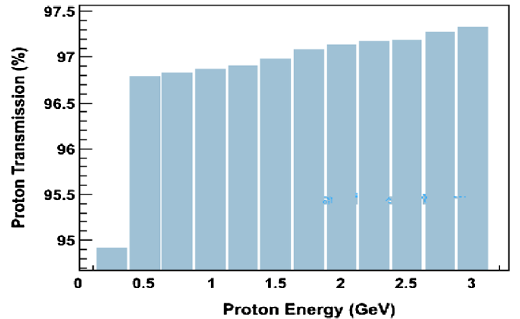
FIG. 7. Variation of pion yield with proton energy.